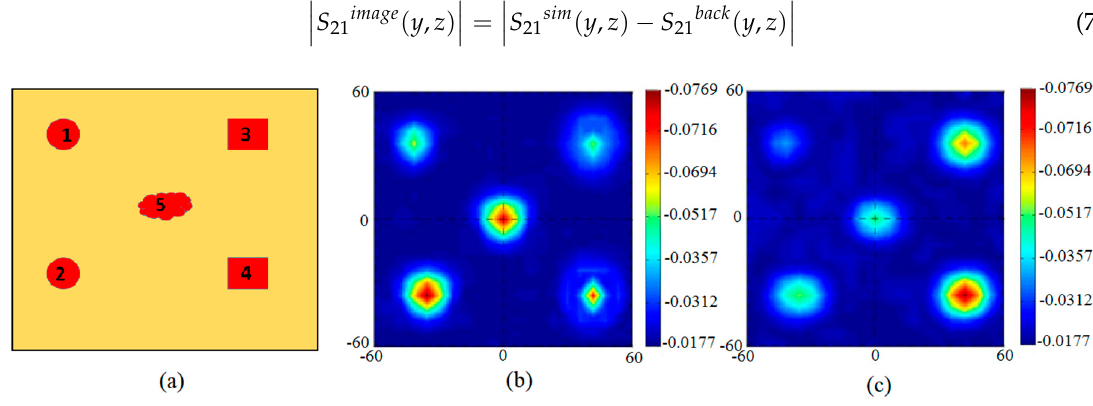
Figure 12. ( a ) Proposed phantom model with selected tumor geometries. ( b ) Calibrated S21 (magnitude) image from 2D scanning at 5 GHz (simulated). ( c ) Calibrated S21 (magnitude) image from 2D scanning at 8 GHz (simulated).